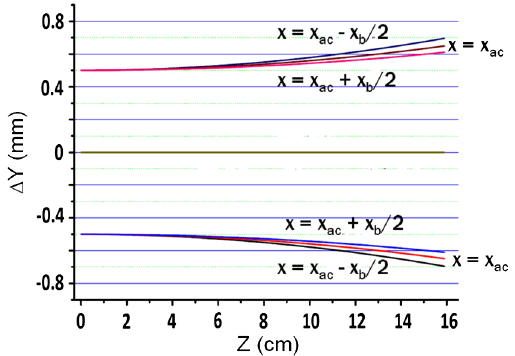
FIG. 7. The vertical ( y ) position of test particles as they move along the structure.